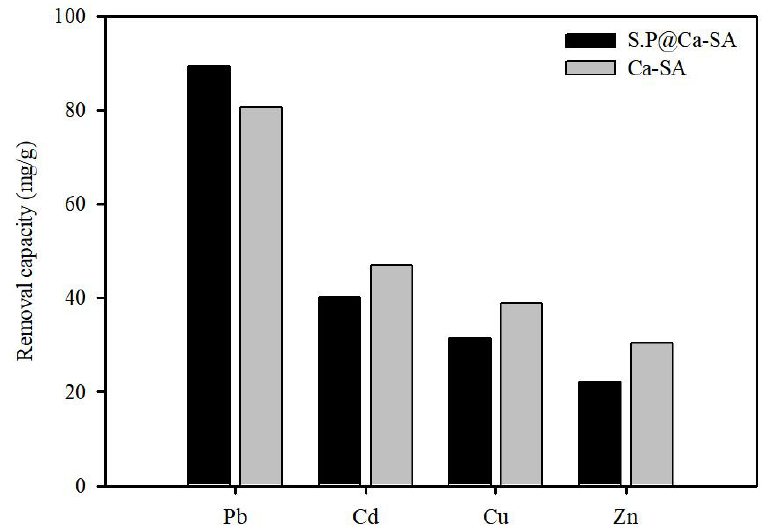
Figure 10. Removal capacity of Ca-SA and S.P@Ca-SA for Pb( Ⅱ ), Cu( Ⅱ ), Zn( Ⅱ ), and Cd( Ⅱ ) ions.